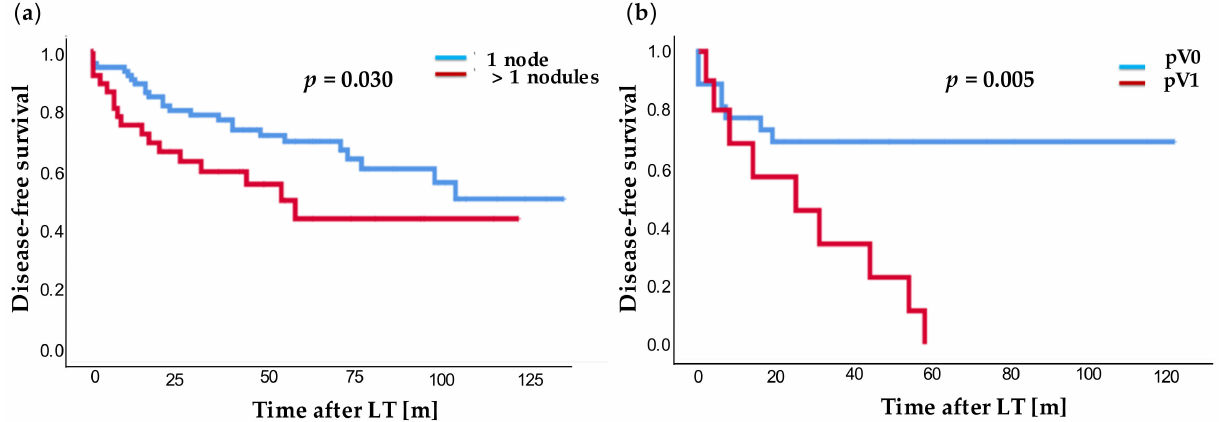
Figure 4. ( a ) Disease-free survival after LT for single (blue) vs. multilocular (red) lesions after LT and ( b ) disease-free survival for patients after LT with multilocular lesions and with microvascular infiltration (red) or without microvascular infiltration (blue). Time in years